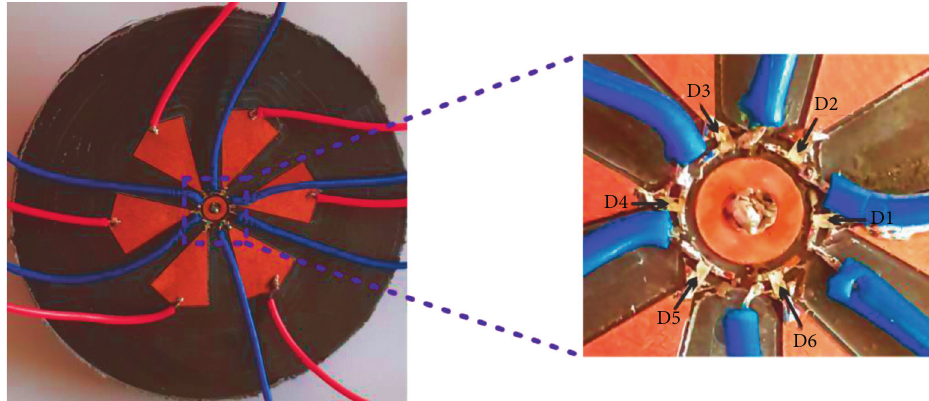
Figure 9: Photograph of fabricated antenna. Table 3: Operating states of the proposed antenna.